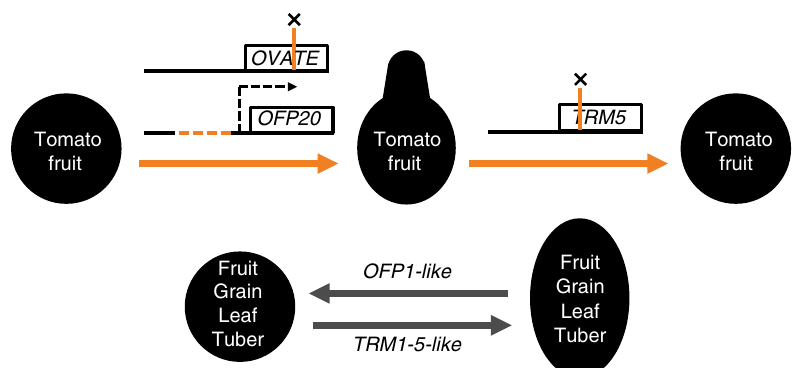
Fig. 7 The OFP-TRM module that regulates plant organ shape. The natural derived allele of OVATE , a true null, and the natural derived allele of SlOFP20 , a deletion in the upstream regulatory region proposed to reduce expression of the gene, result in pear-shape tomato fruit. A CRISPR-Cas9 induced frame shift mutation in SlTRM5 rescues the fruit shape phenotype to a nearly round fruit. In general, the TRM1 – 5-like genes promote the elongation of fruit, grain, leaf and tuber, whereas OFP1-like genes play an antagonistic